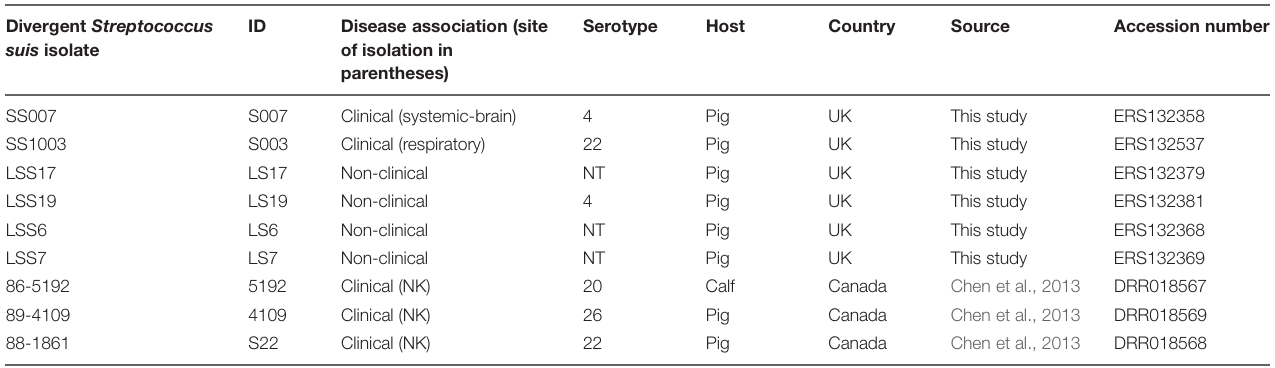
TABLE 1 | Phenotypic characteristics of the divergent